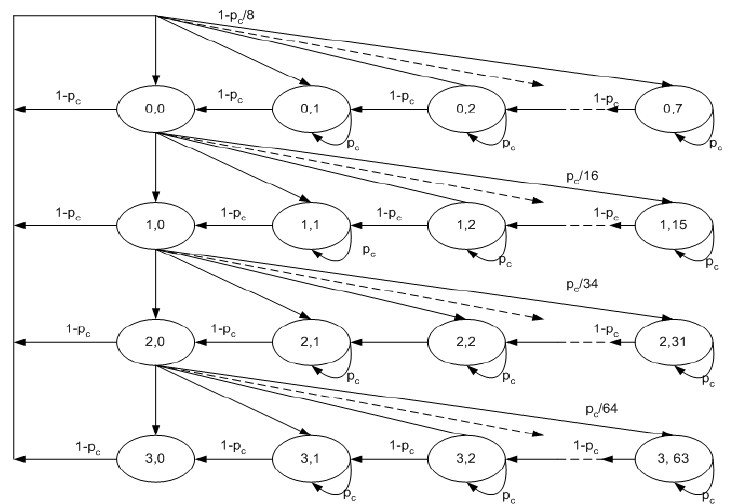
Figure 6. Markov Chain Model for IEEE